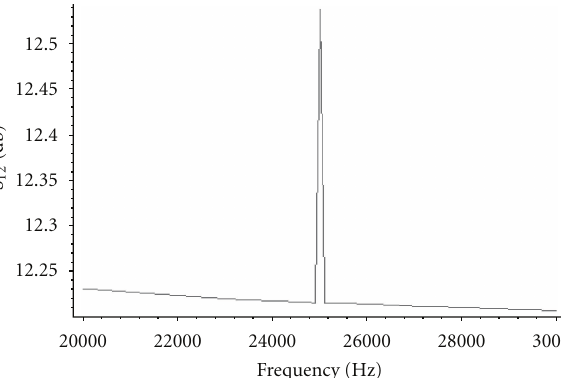
Figure 11: Frequency response of the piezoelectric ZnO cantilever sensor ( S 12